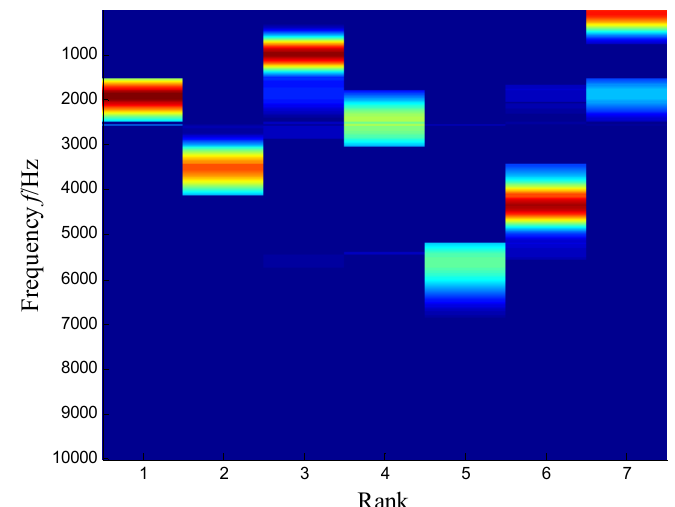
Figure 19. Coefficient matrix obtained by SNMF.